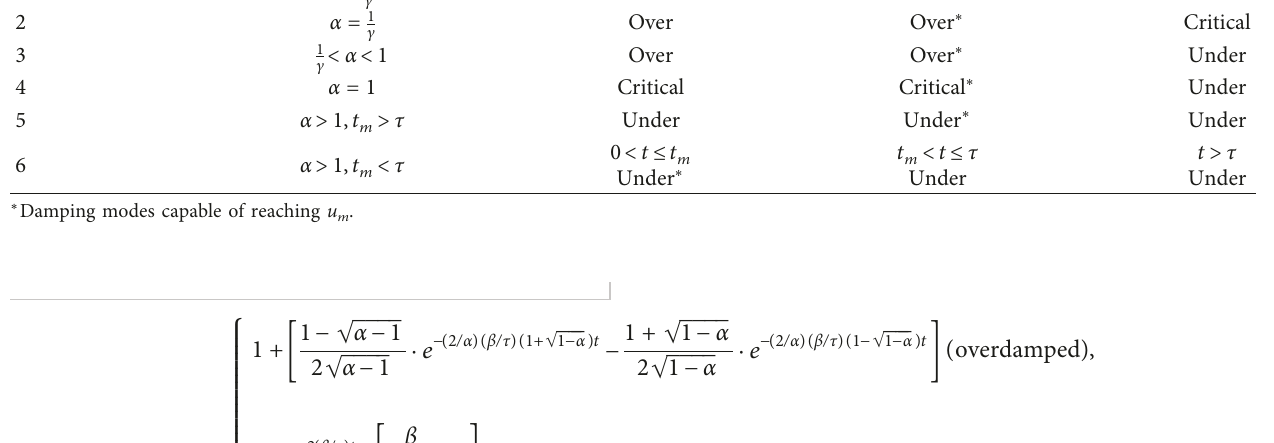
Table 2: Dynamic drill-bit properties for loading, unloading, and τ , and the damping modes capable of reaching u Case